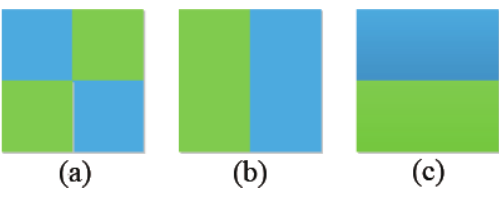
Figure 4. A particular target model.